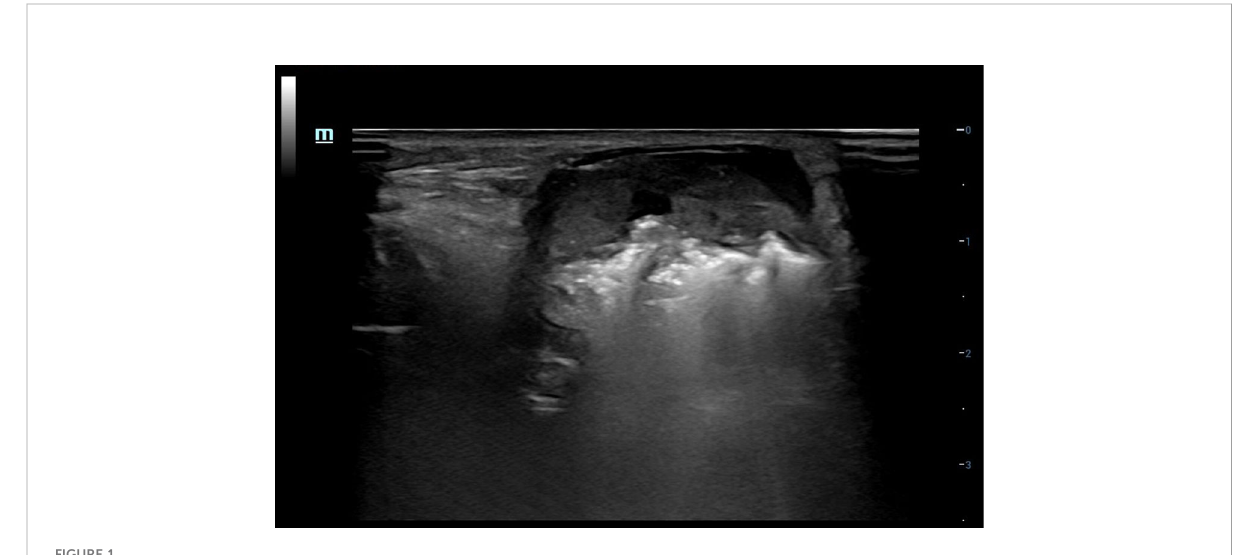
FIGURE 1 US-guided RFA for left cervical